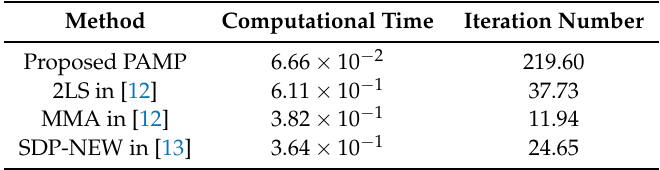
Table 4. Average computational time (in seconds) and average iteration number in scenario 2, Gaussian noise.